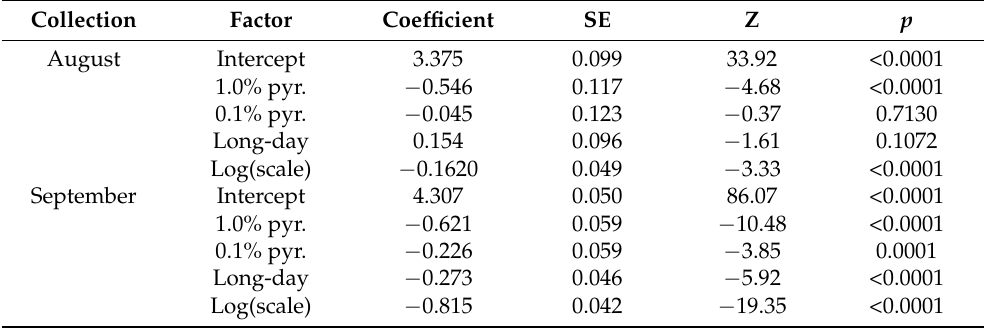
Figure 2. Survival curve for the August collection showing differences in the instantaneous survival probability between the acetone (red solid line), 1.0% pyriproxyfen (blue dashed line), and 0.1% pyriproxyfen (green dotted line) treatments, separated by photoperiod treatment. Shaded areas represent 95% confidence intervals. Table 1. Regression coefficients and predictors from the AFT survival model. Survival of Megacopta cribraria decreased significantly due to 1.0% pyriproxyfen and long-day treatments in the August experiment and by all treatments in the September experiment. The model intercept represents the long-day + acetone treatment, which serves as the referent group.